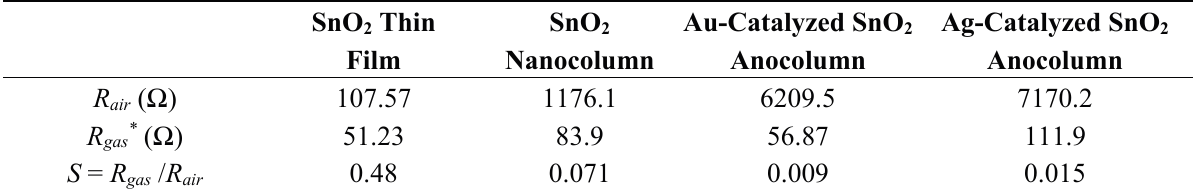
Table 1. Resistance and H 2 S sensitivity of the sensors measured at 300